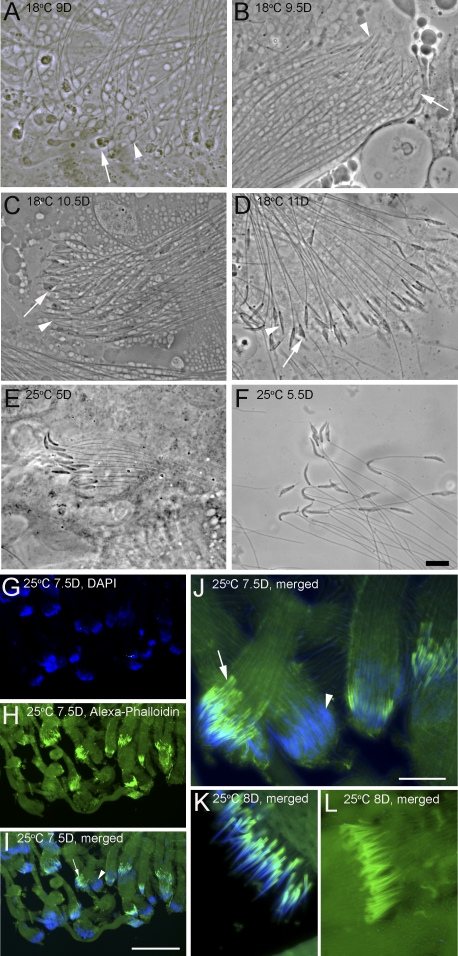
Critical Stage for Temperature SensitivityFive spermatid bundles of the most advanced stage from each of the five gonads or testes were examined at each critical point of the temperature shift experiment under phase contrast optics (A–F) or epifluorescence (G–L). Spermatid development stages (p to s) were classified according to the standard described in [41]. Scale bar: 10 μm (A–F); 100 μm (G–I); 20 μm (J–L).(A–D) Spermatogenesis at 18 °C before the early middle stage of elongation (stages p or q) can be rescued for sex-ratio by shifting to 25 °C (A; also see Figure 6). However, when spermatogenesis reaches late middle stage of elongation (stage r), the rescue is almost impossible (B–D). Thus, stage r is the late boundary of temperature sensitivity. Note the phase dark nucleoplasmic vacuoles in the abnormal nuclei (arrow) as compared to normal nuclear transformation (arrowhead). (E and F) Spermatogenesis at 25 °C up to the middle stage of elongation (stages q and r) can be affected by 18 °C treatment to give full sex-ratio (E). However, the temperature sensitivity decreases once the spermatogenesis reaches the fully elongated stage (stage s) (F).(G–L) Individualization complex (IC) is viewed with Alexa Fluor 488 Phalloidin that binds to F-actin (green) while the nuclei are marked by DAPI (blue). By the beginning of individualization (arrow in I and J, where J is a closeup of I; compared to a younger bundle in which the IC has not formed yet, arrowhead), the 18 °C treatment can only cause a slight sex ratio distortion (Figure 6B). On the 8th day of spermatogenesis at 25 °C, there are numerous spermatid bundles that have initiated individualization (K) or that have the IC traversing along the tails (L). The 18 °C treatment has no effect from this time on.